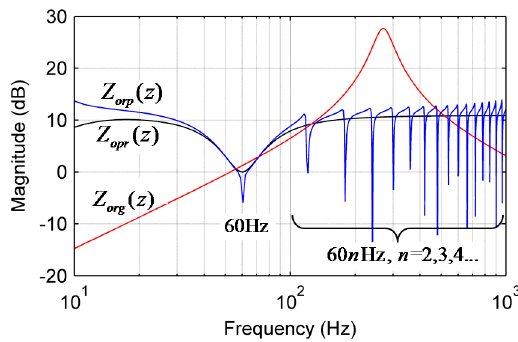
Figure 6. Comparison of the output impedances under different control structures.